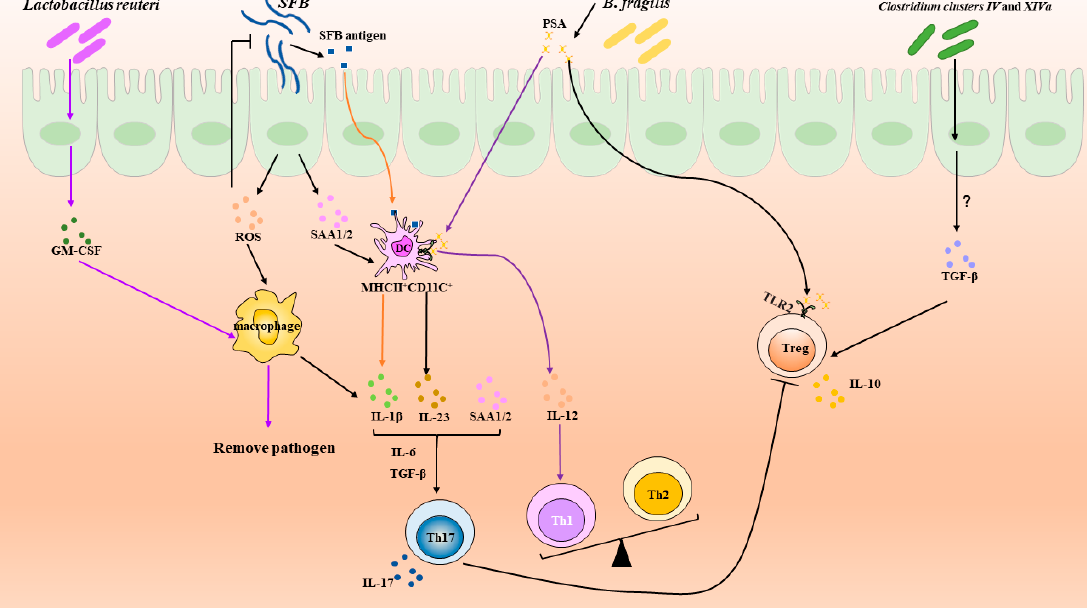
Table 1. The function of di ff erent species Bifidobacterium strains in human immune system